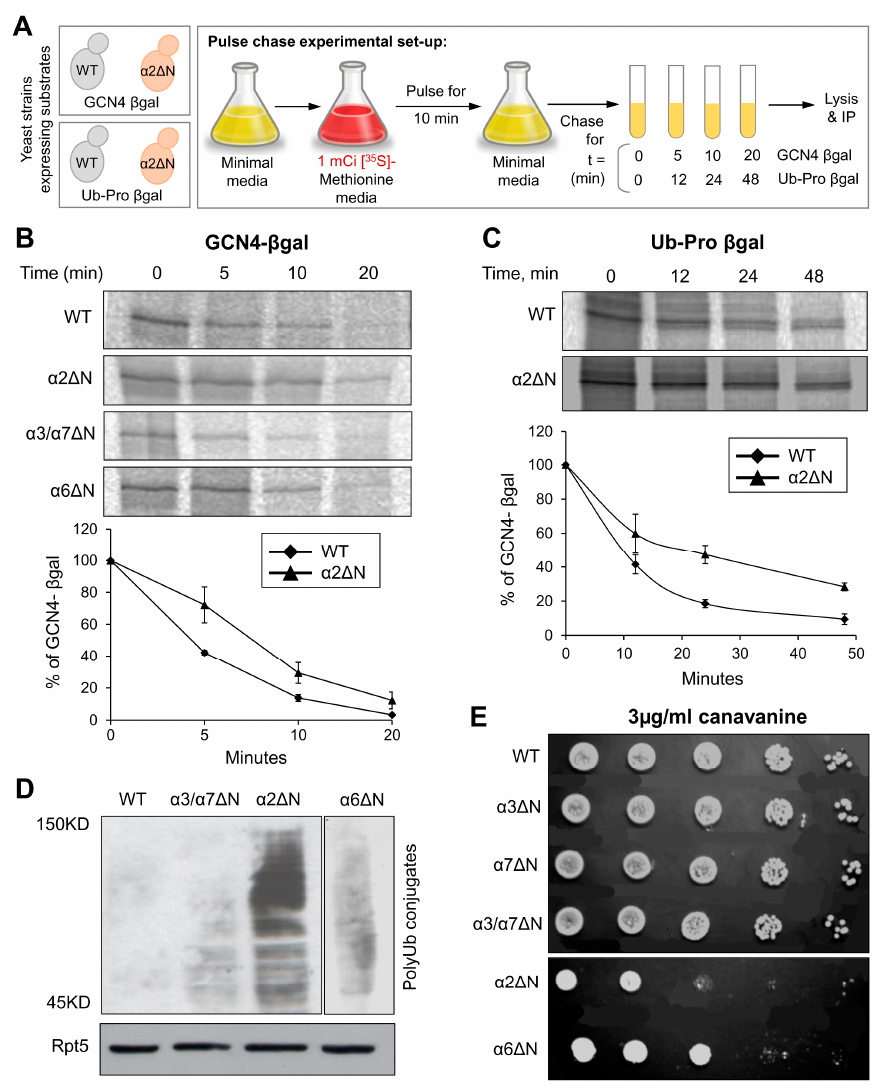
Figure 4. The α 2 Δ N mutant shows defects in intracellular proteolysis. ( A ) Pulse-chase experimental setup. GCN4- β -galactosidase or Pro- β -galactosidase substrates were expressed in WT and α subunit Δ N mutants. After a 10 min pulse with [ 35 S]-methionine, excess unlabeled Met was added to initiate the chase incubation (t = 0). At the time indicated, cells were rapidly lysed, and the relevant substrate was immunoprecipitated. ( B ) GCN4- β -galactosidase from WT, α 2 Δ N, α 6 Δ N and α 3/ α 7 Δ N strains; and ( C ) Ub-Pro- β -galactosidase from WT and α 2 Δ N strains were immunoprecipitated by anti- β - galactosidase antibody and resolved by SDS-PAGE and quantified by a phosphoimager. Line graphs represent% of GCN4- β -galactosidase or Ub-Pro- β -galactosidase depletion estimated from three independent experiments each. ( D ) Ub-conjugates in WT and mutant strains indicated. Whole-cell extracts from different strains were separated by SDS-PAGE and immunoblotted with an anti-Ub antibody. Immunoblotting with anti-Rpt5 indicates identical proteasome levels in these extracts as a control. ( E ) Growth rates of WT and α subunit Δ N mutant strains during moderate stress of canavanine. Growth rates were tested by serial dilution onto 3 µg/mL canavanine plates.